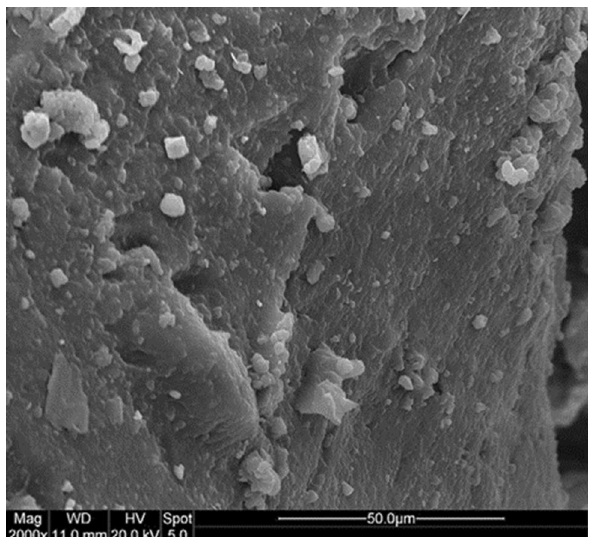
Fig. 18 2000 × magnification of crumb rubber [70]